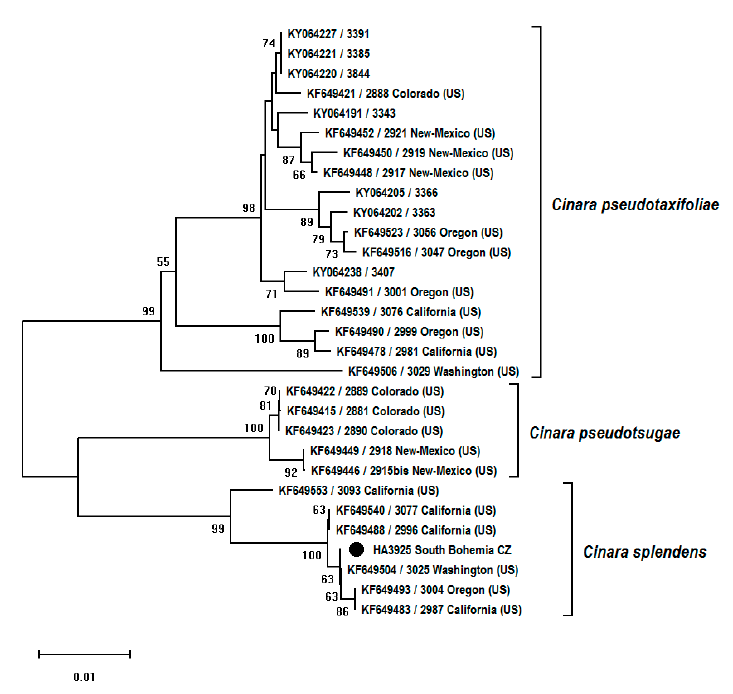
Figure 4. Neighbor-joining tree (p-distances, 1000 bootstrap replications) based on COI fragment (658 bp) of species of the genus Cinara collected from Pseudotsuga spp. Bootstrap values over 50% are shown next to branches. The sample from the Czech Republic is marked with a black circle. Forests 2020 , 11 , x FOR PEER REVIEW